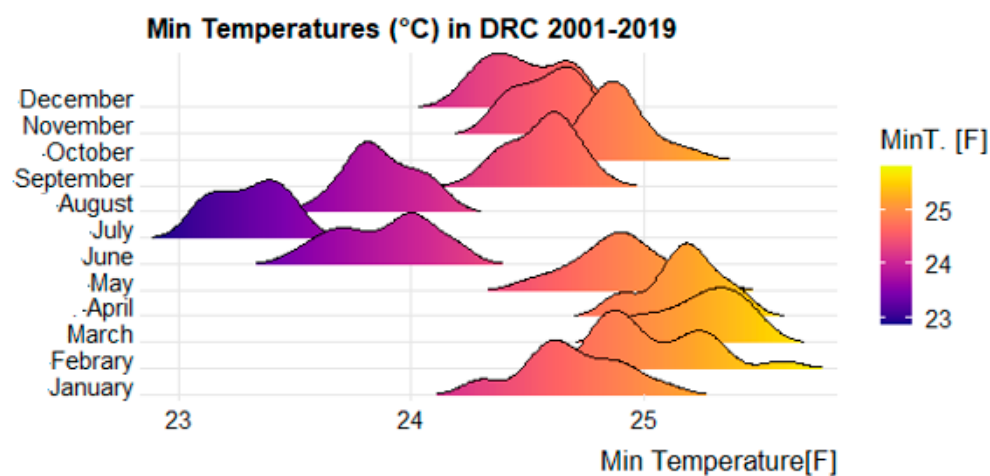
Figure A5. Minimal temperature (°C) in DRC (2001–2019).